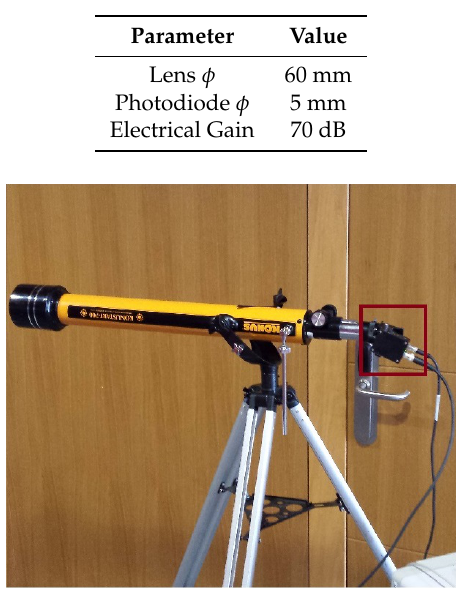
Figure 12. Receiver Assembly. The photodiode used for the data capture is highlighted in